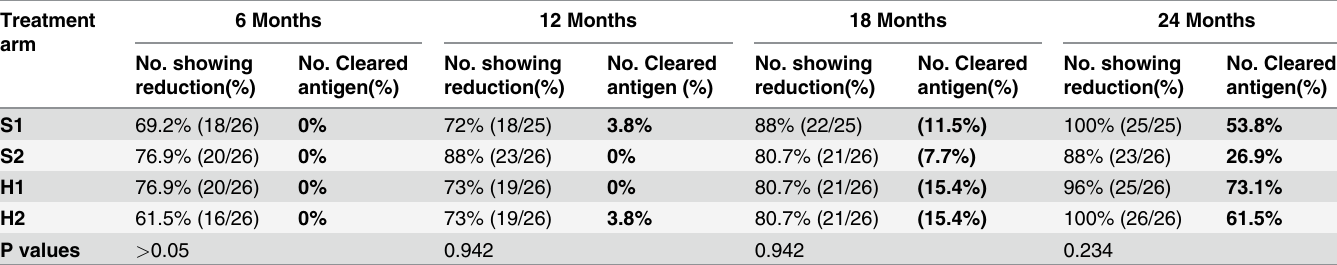
Table 7. OG 4 C 3 antigen status in 4 regimens group in different time points followed. Treatment